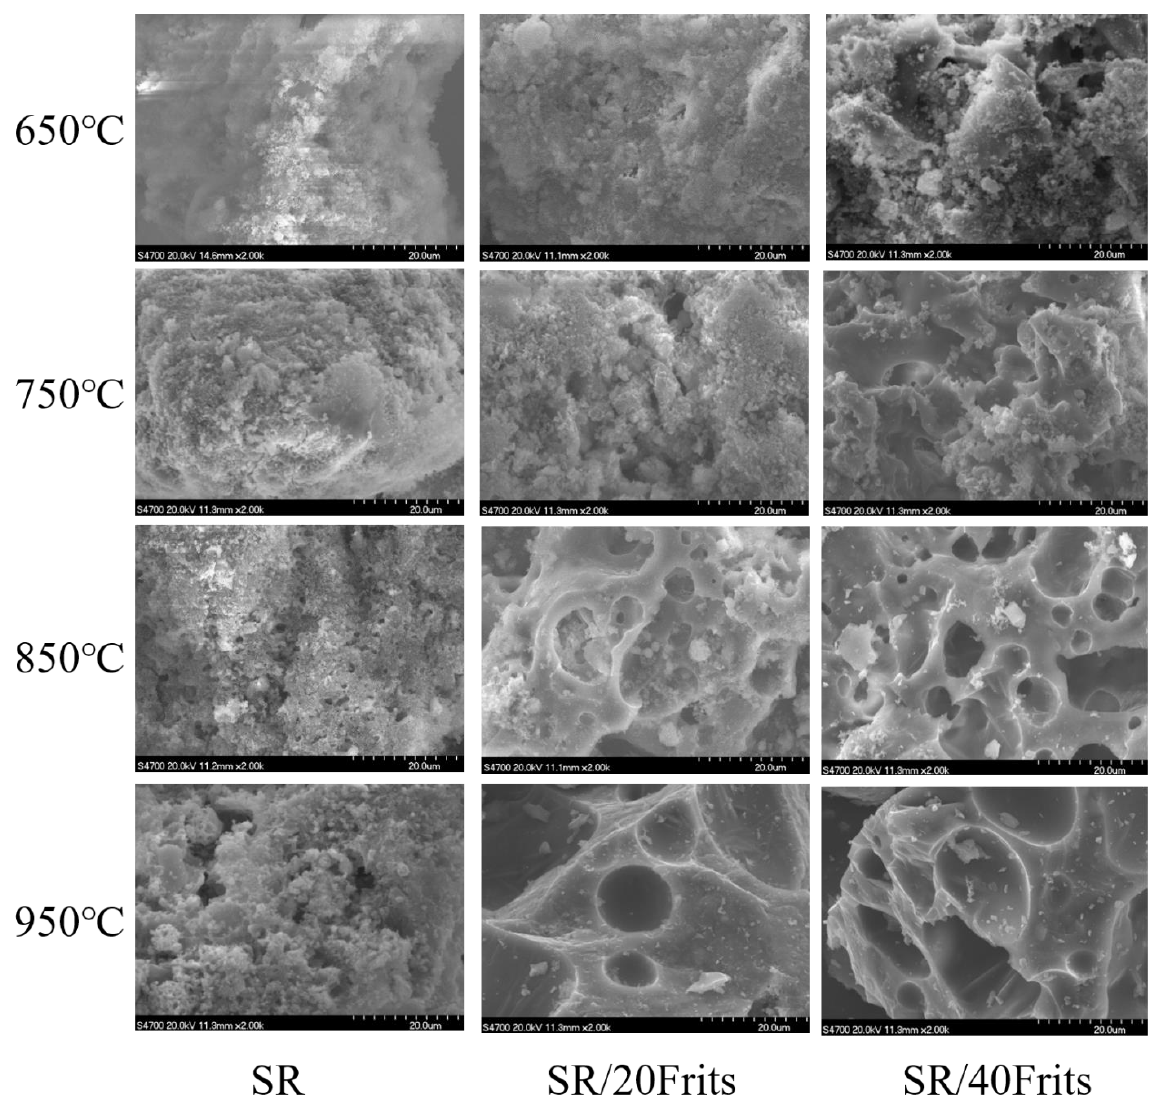
Figure 8. SEM images of the ceramics of SR, SR/20Frits, and SR/40Frits at different